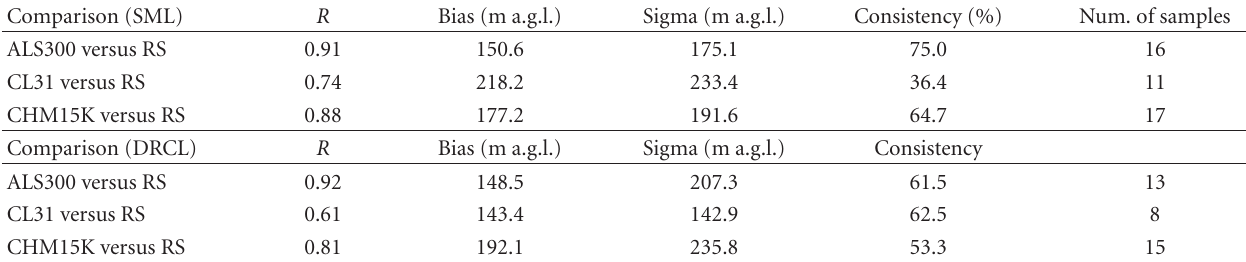
Table 3: Mean statistical parameters of the ALS300-CHM15K-CL31 versus radiosounding (RS) comparison. For each X versus Y comparison, R is the correlation coe ffi cient, bias = abs ( Y - X ), Sigma = std ( Y - X ), and consistency is percentage of X versus Y detections closer than 200 m, that is, abs ( Y - X ) ≤ 200 m.